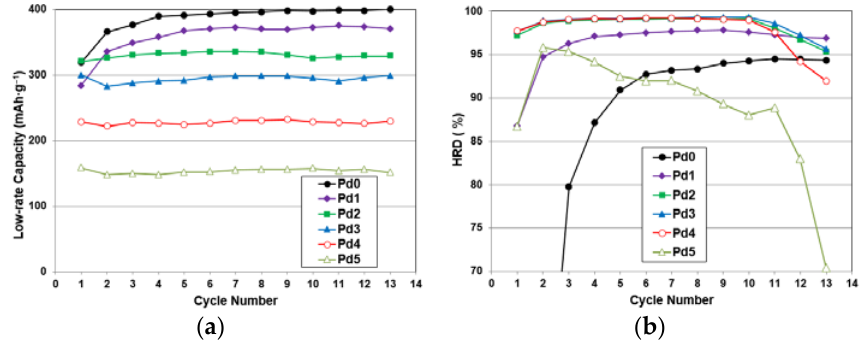
Figure 12. Activation behaviors observed from ( a ) full capacity and ( b ) HRD for the first 13 electrochemical cycles measured at room temperature.